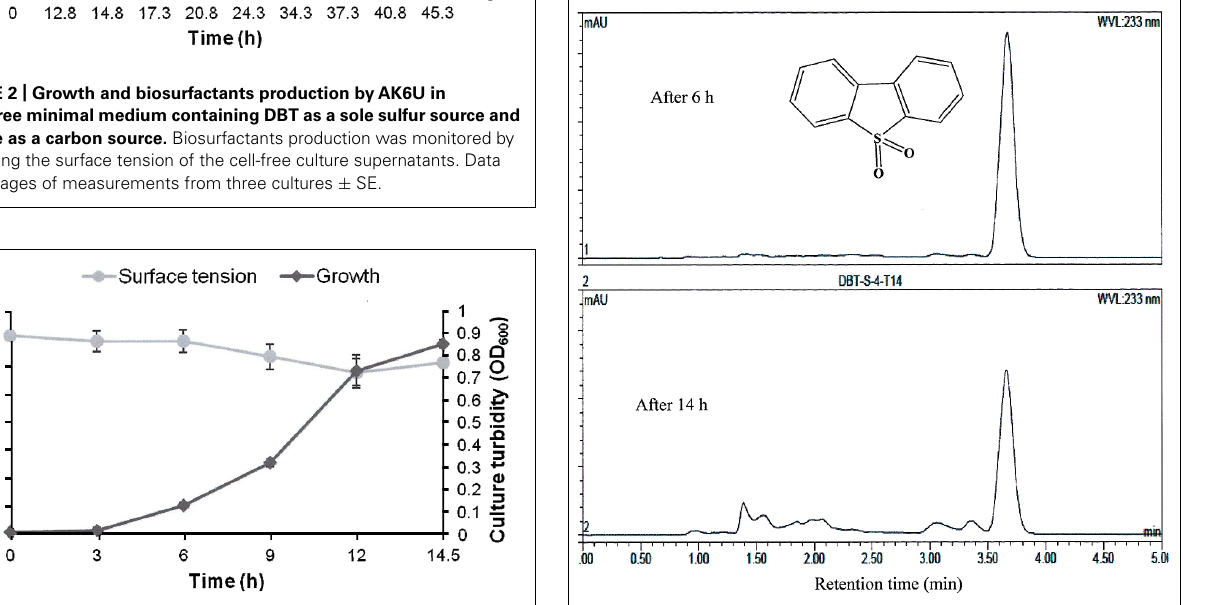
FIGURE 3 | Growth and biosurfactants production byAK6U in sulfur-free minimal medium containing DBT-sulfone as a sole sulfur source and glucose as a carbon source. Biosurfactants production was monitored by measuring the surface tension of the cell-free culture supernatants. Data are averages of measurements from three cultures ± SE.